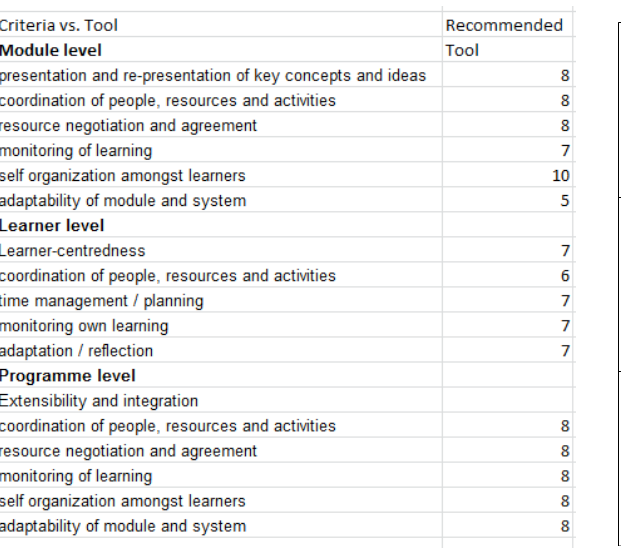
Figure 4. An example of the Recommendation Unit Output Figure 5. Structural